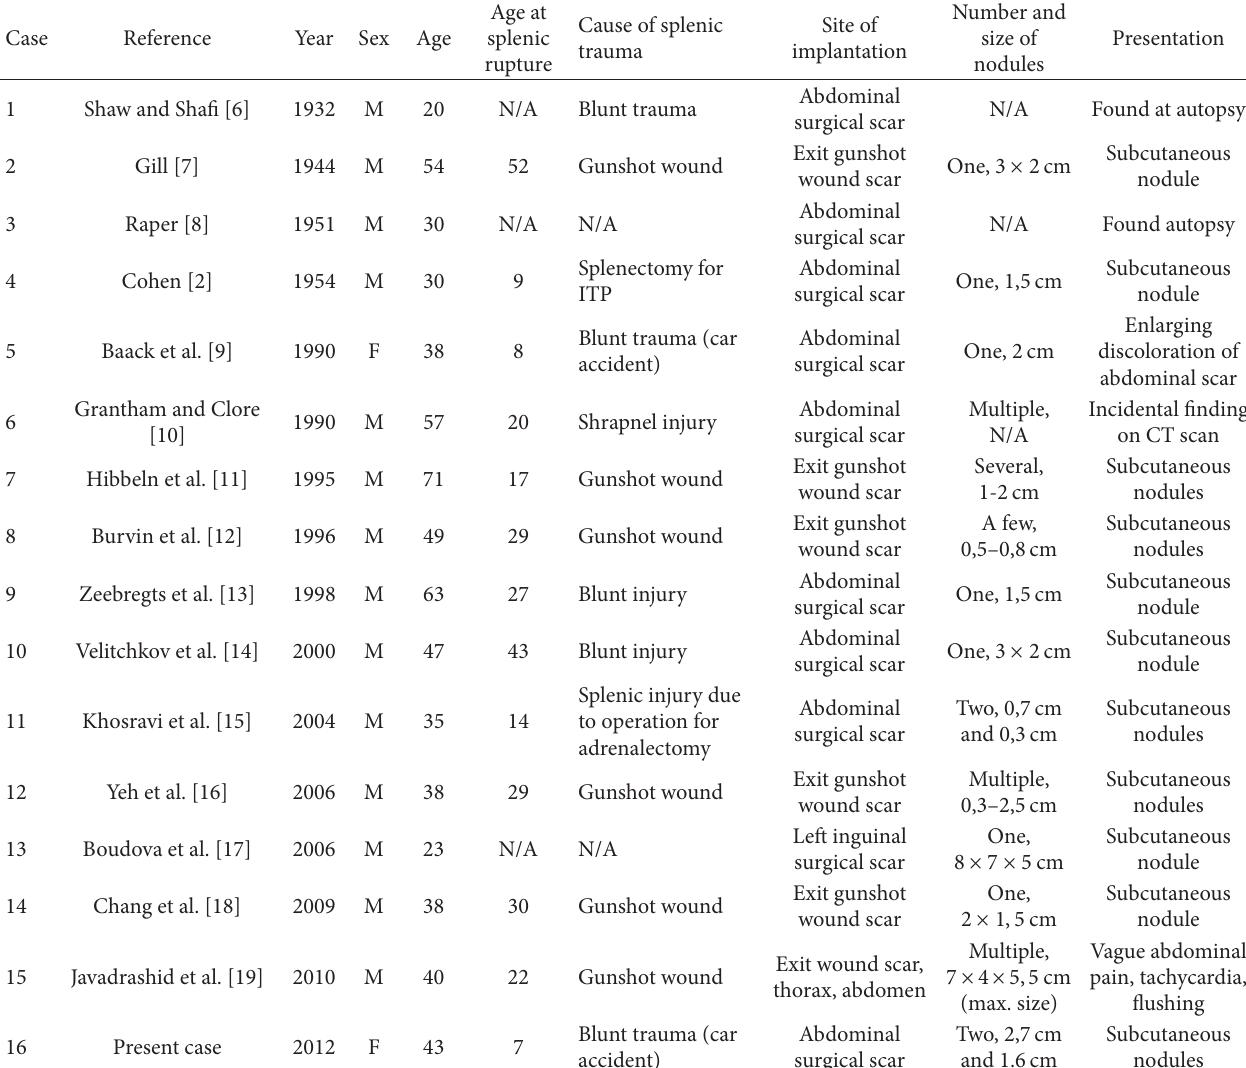
T 1: Reported cases of subcutaneous